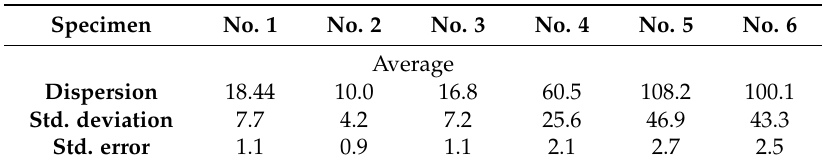
Table 7. Comparison of selected parameters of statistical analysis between different methods of travel time identification in bender element testing.